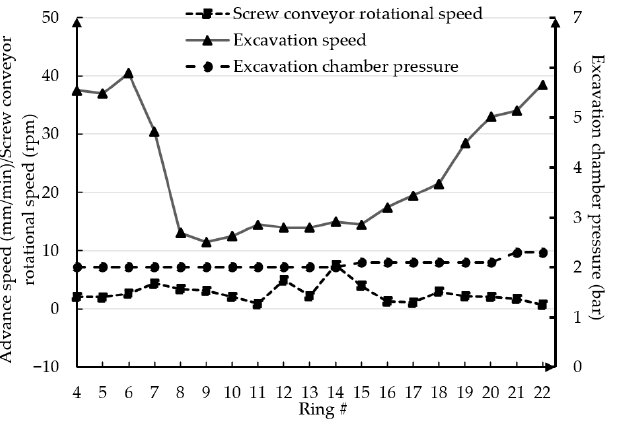
Figure 5. Excavation speed, screw conveyor rotational speed, and excavation chamber pressure variation of the studied tunnel section.